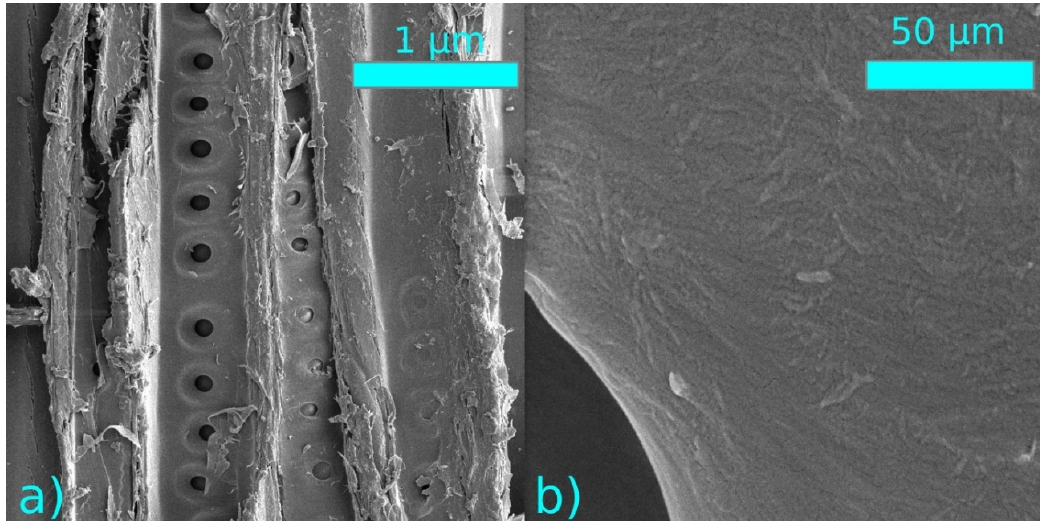
Figure 11. SEM images of plasma treated samples at a distance of 1 mm from the electrode ( a ) 1000× magnification, ( b ) 50,000× magnification.